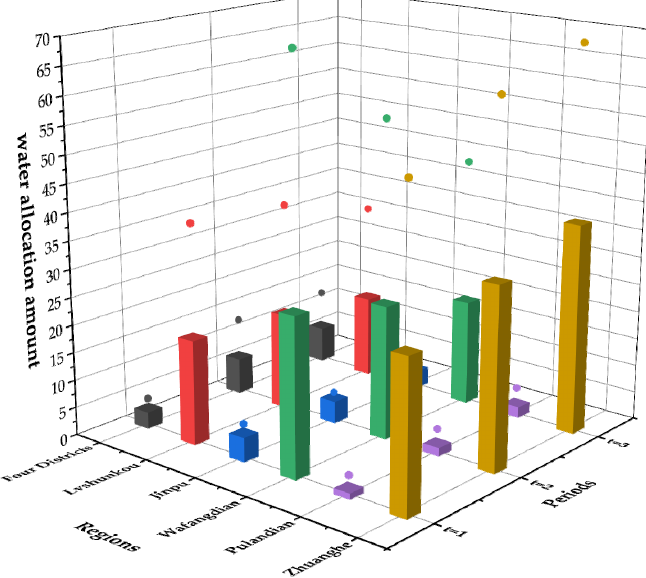
Figure 4. Reused water resource allocations for industry (10 4 m 3 /year).